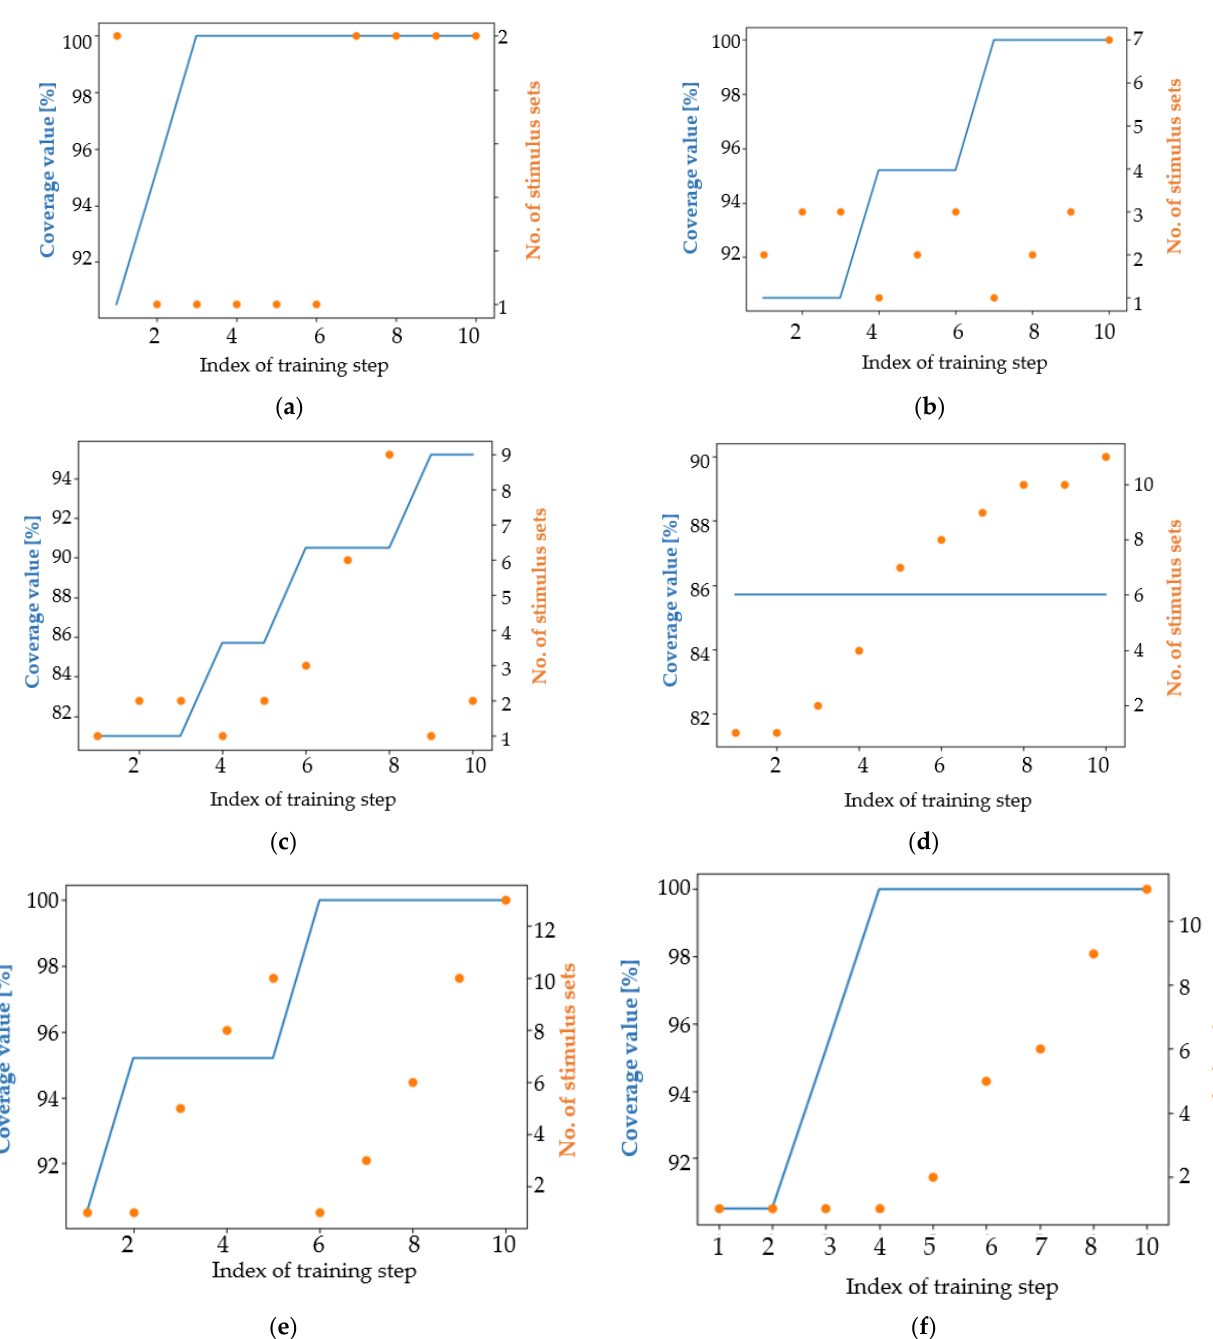
Figure 13. First 10 learning iterations for each approach considering the main coverage target when the mutation coefficient is 5%. The label “proposed” is attached to plots related to the approaches developed and proposed during current study. The blue line shows the coverage value reached by the best performing element in the population at that training step. The orange dots show how many individuals reached the highest coverage value met at each training step. For example, in sub-figure ( e ), at the seventh training step, the population contained three individuals reaching 100% coverage. For sub-figure ( c ), the best individuals in the initial population reached 81% coverage. For sub-figure ( d ), the best individuals in the populations at each training step reached 85.7% coverage. For sub-figures ( a , b , e , f ), the best individuals in the initial population reached a coverage of